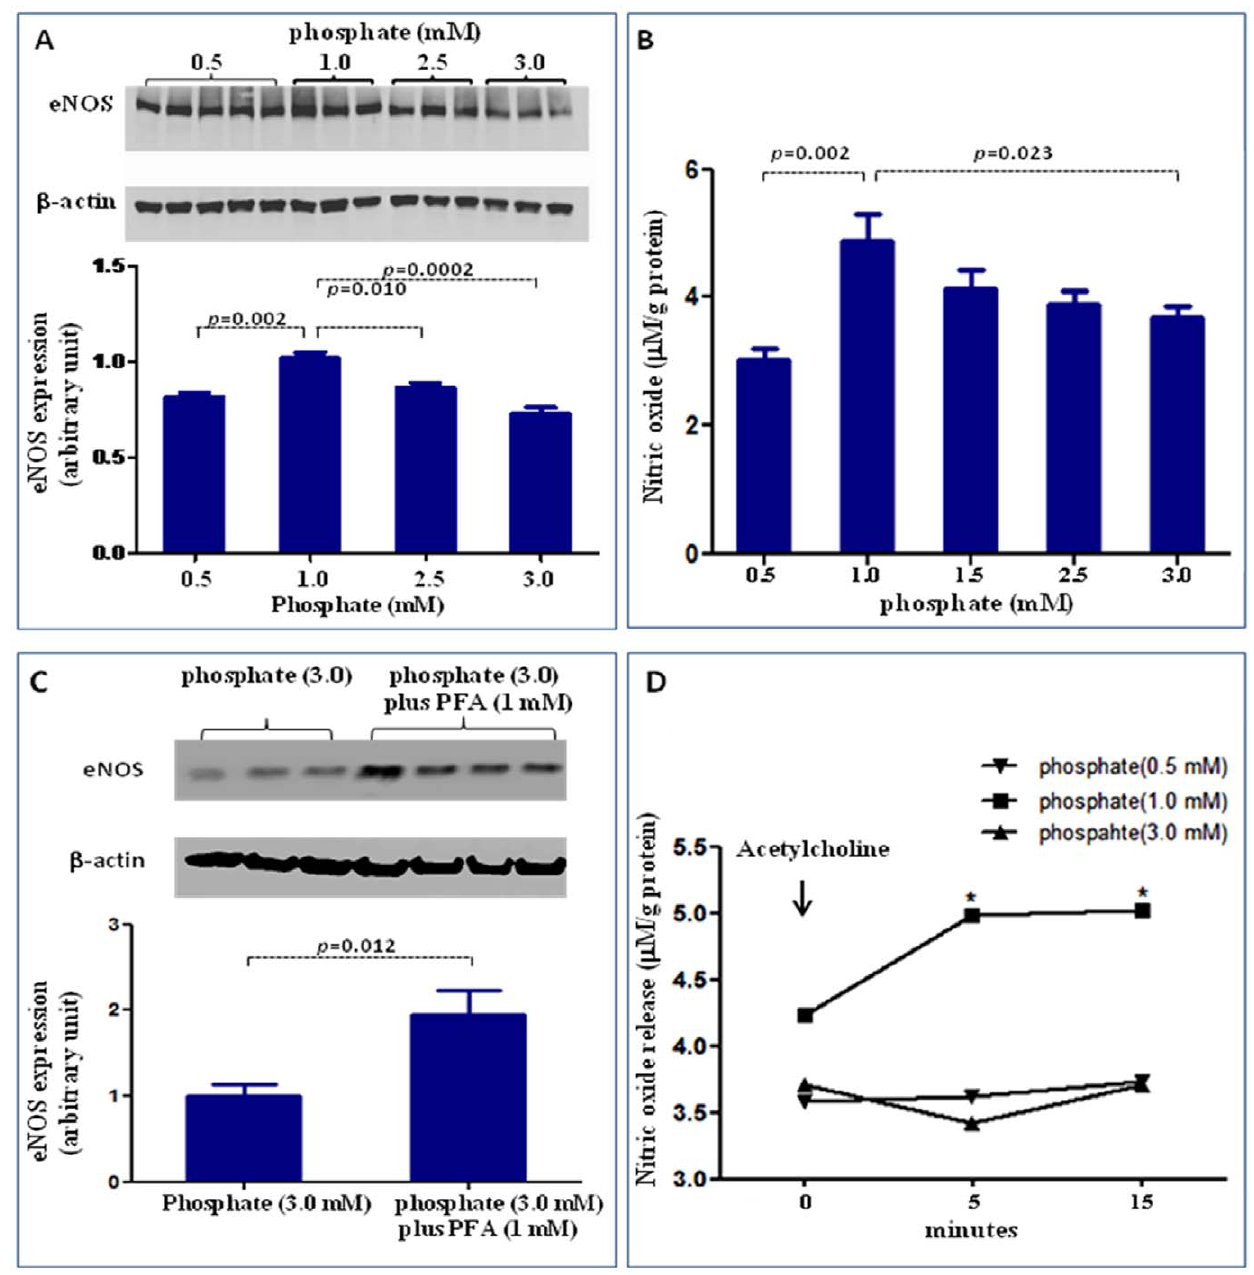
Figure 3. Effect of inorganic phosphate on eNOS expression and NO production . We examined the effect of exposure to different concentrations of inorganic phosphate for 24 hours on NO production and eNOS expression. Incubation in media simulating hypophosphatemia (0.5 mM) or hyperphosphatemia (3 mM phosphate) resulted in a significant reduction in eNOS expression (A) and NO production (B). The down- regulation of eNOS following exposure to simulated hyperphosphatemia (3 mM phosphate) was reversed with co-administration of 1 mM PFA, which is a specific inhibitor of phosphate transport across the cell membrane (C). To determine whether abnormal phosphate levels affected the ability of acetylcholine (a physiological activator of eNOS) to stimulate NO production, a set of cells was incubated with 2 m M acetylcholine and the supernatant NO levels before (0 minute) and 5 minute and 15 minute post acetylcholine stimulation was measured. As shown in (D), incubation in medium with 1 mM phosphate resulted in a significant NO production 5 minute post acetylcholine stimulation and remained elevated at 15 minutes. In contrast, incubation in media simulating both hypophosphatemia (0.5 mM) and hyperphosphatemia (3 mM phosphate) completely prevented acetylcholine-induced stimulation of NO generation, pointing to endothelial dysfunction. p values vs control (1 mM phosphate). N=6 ,